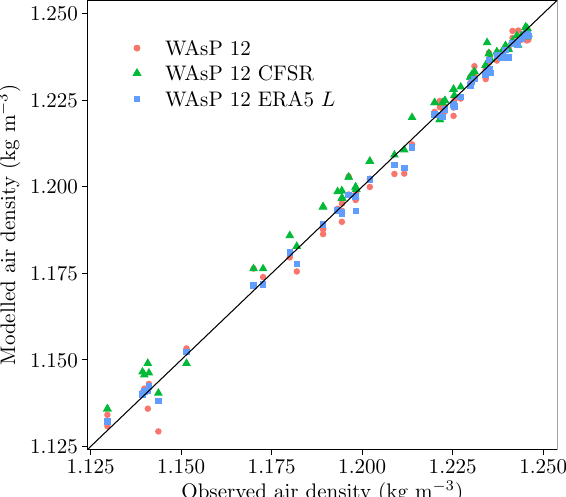
Figure 4. Scatter plot of the different modelling approaches. Note that the point from the Zugspitze station is omitted because it had a very low ρ which reduced the readability of the